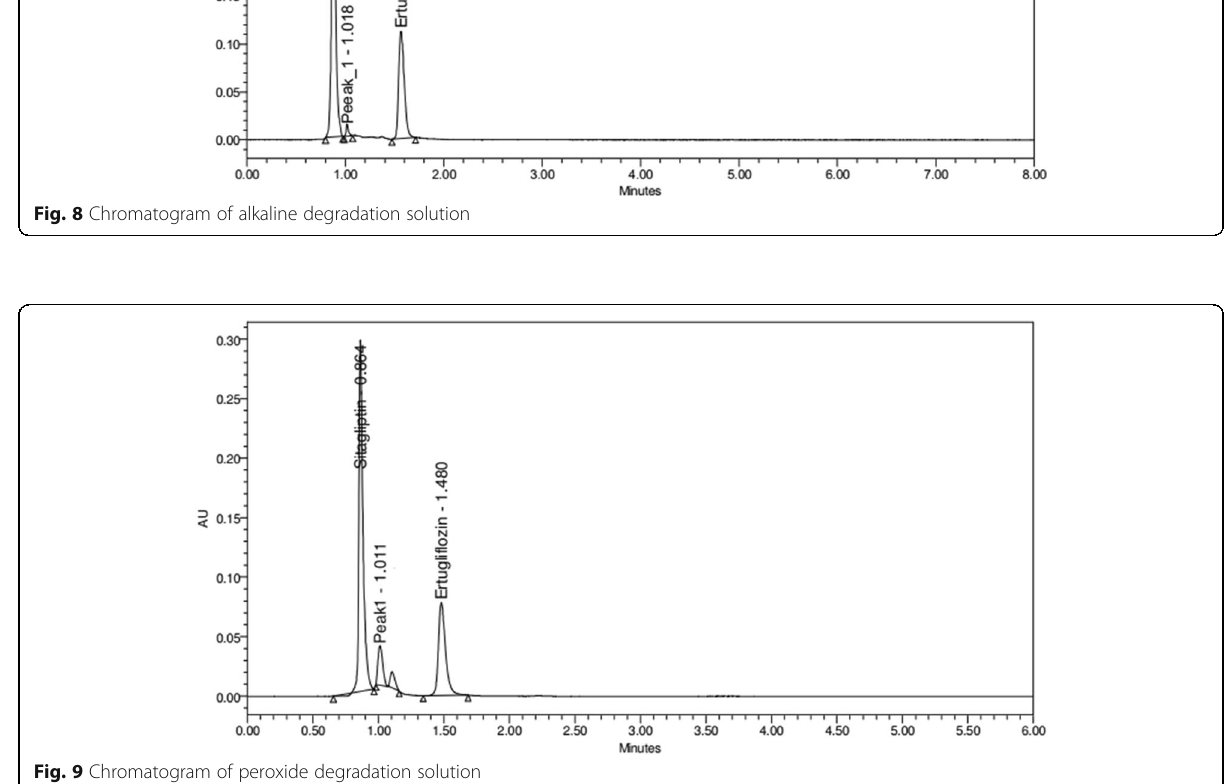
Fig. 9 Chromatogram of peroxide degradation solution